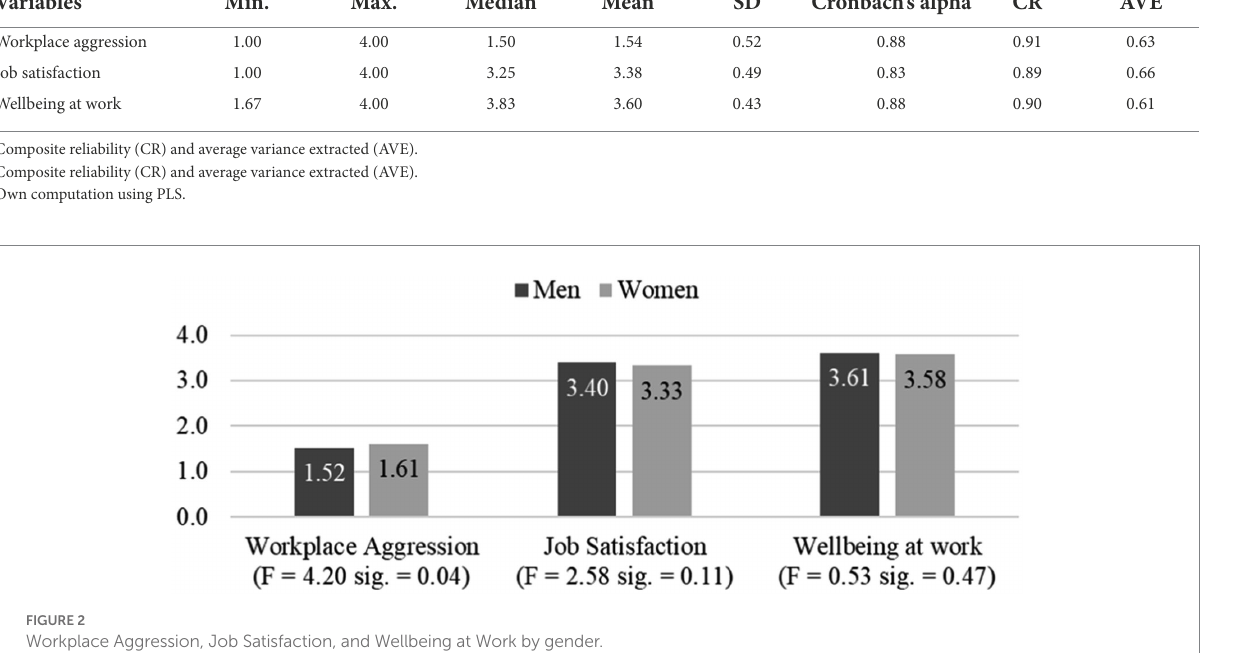
TABLE 2 Descriptive statistic, and reliability of measure ( N = 1,066). Variables